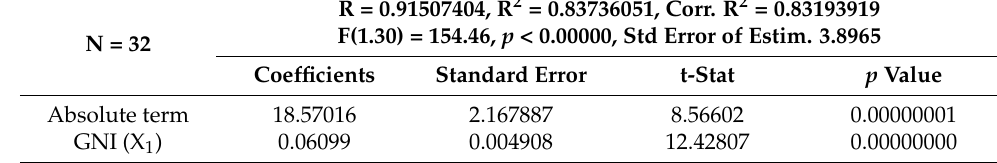
Table 5. Results of modeling the share of renewable energy sources in gross marginal energy consumption in Sweden in 1991–2022 using a linear econometric model of one variable. R = 0.91507404, R 2 = 0.83736051, Corr. R 2 = N = 32